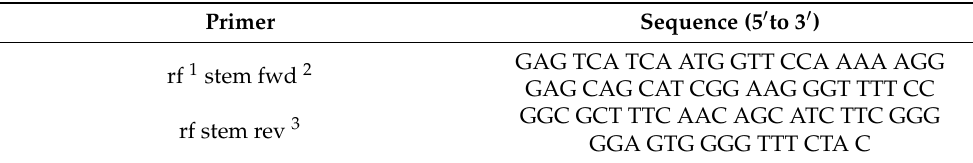
Table 1. Primers used in the first PCR to amplify the “megaprimers” for the second PCR. Primer Sequence (5 (cid:48) to 3 (cid:48)